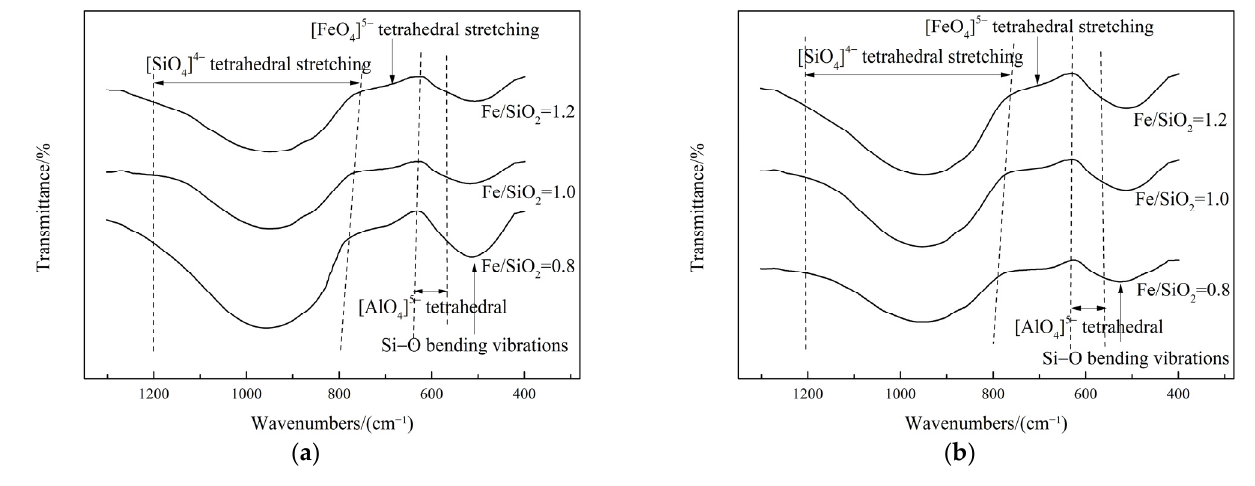
Figure 7. FTIR spectra of quenched samples at different Fe/SiO 2 ratios with Fe 2 O 3 content of ( a ) 12 wt% and ( b ) 16 wt%.